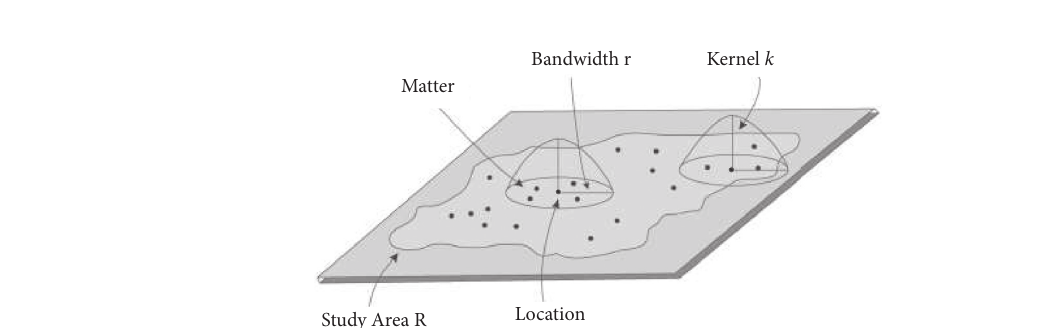
Figure 1: The flowchart of this article.